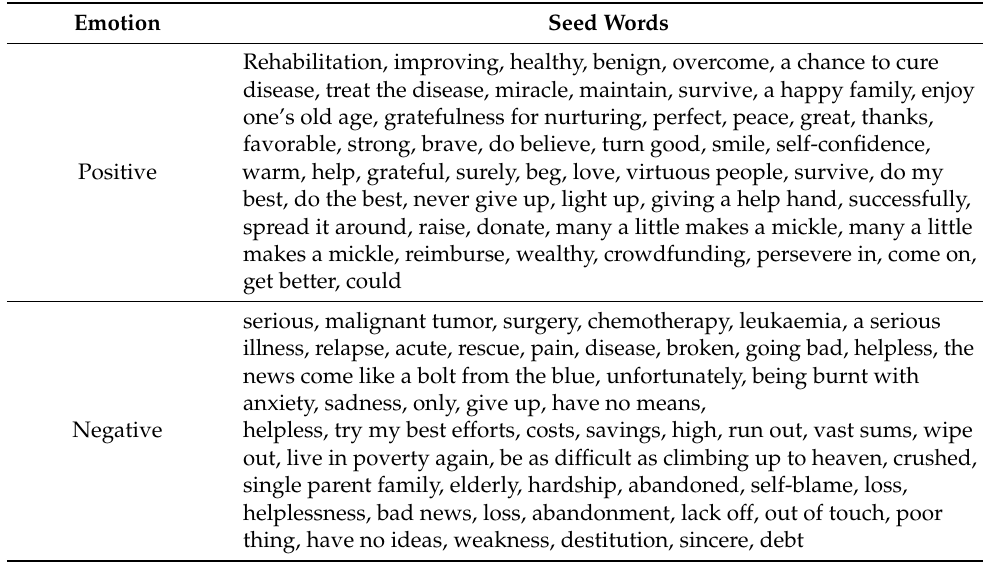
Table A3. Sentimental seed words.